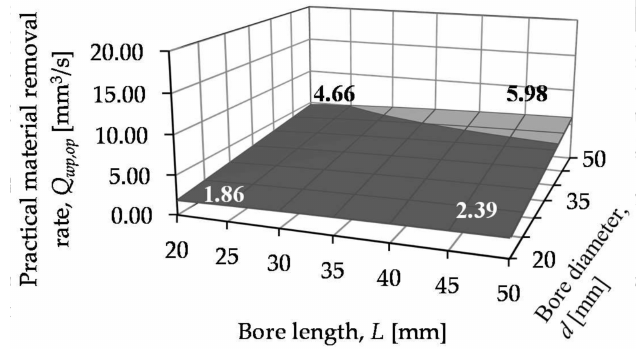
Figure 4. Q wp,op values of grinding.